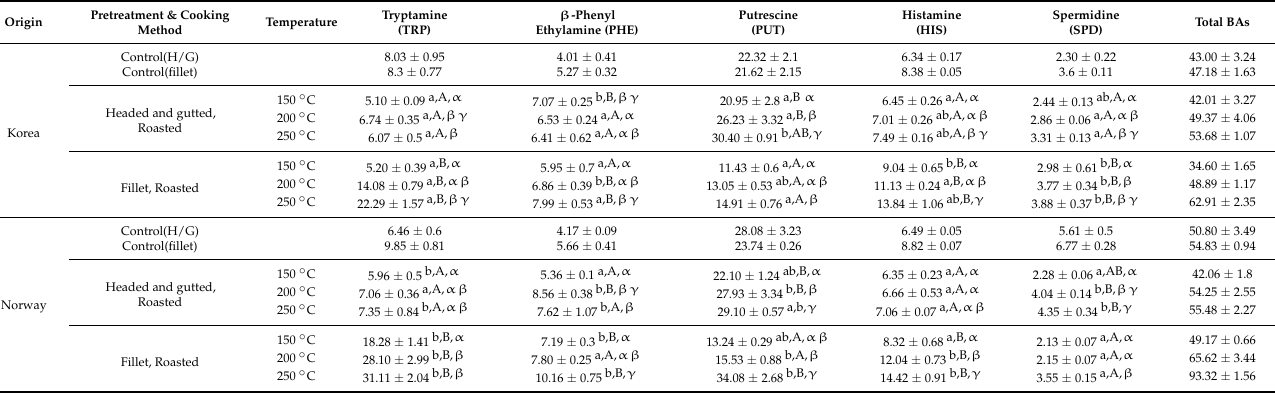
Table 3. Concentrations of BAs in roasted mackerel samples.